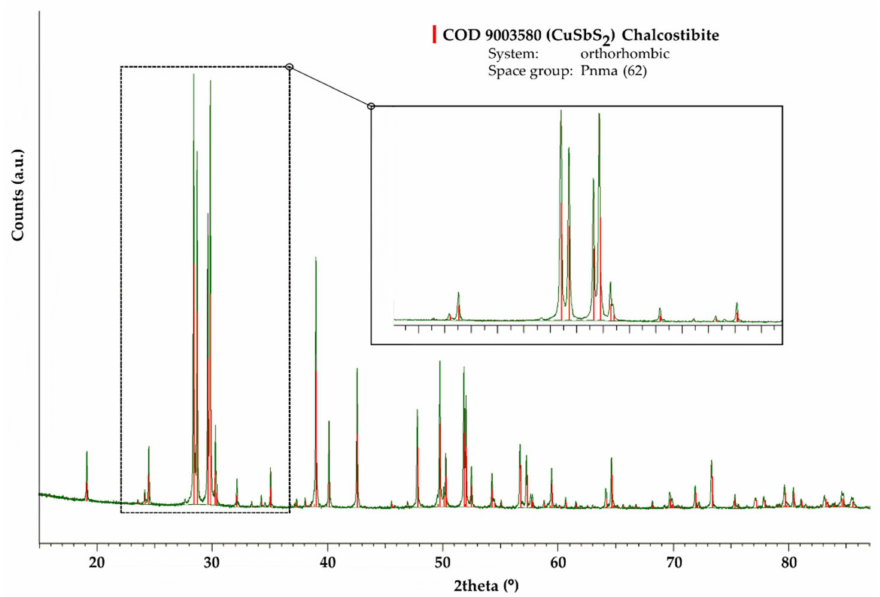
Figure 6. XRD pattern of mechanochemically synthesized CuSbS 2 powders heat-treated at 350 ◦ C/24 h (solid green line—observed XRD pattern, thin black line—background).